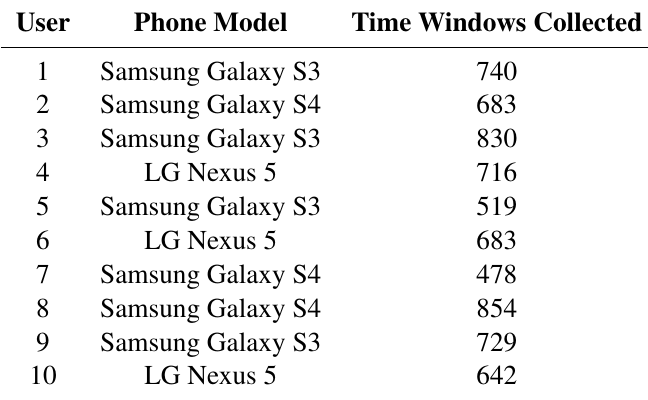
Table 1. Distribution of users’ smartphones during the